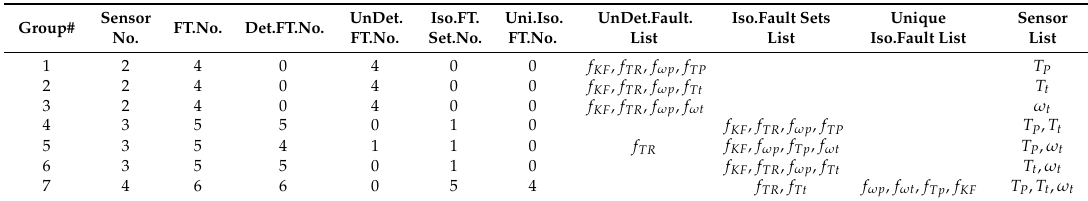
Table 3. Results of the sensor placement for the